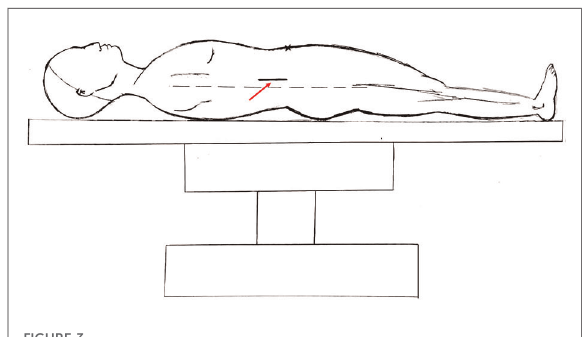
FIGURE 3 Hand drawing of retroperitoneal abscess drainage through a small incision in the right lumbar region. The red arrow points to the location of the incision, approximately 3 – 5 cm. the dotted line is the mid-axillary